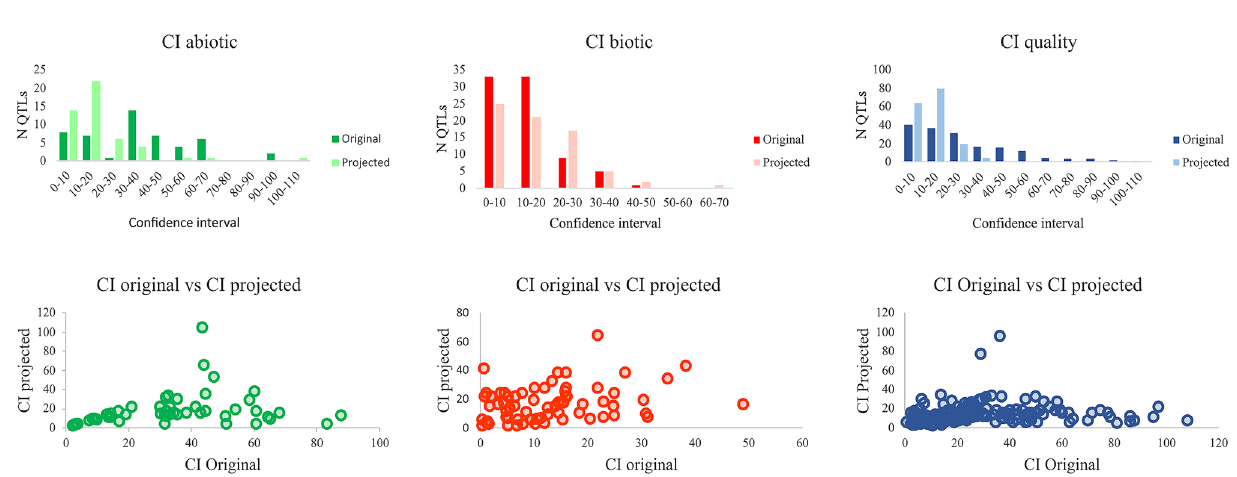
Figure 3. Comparison of confidence intervals for original and projected QTL and their correlation for the different